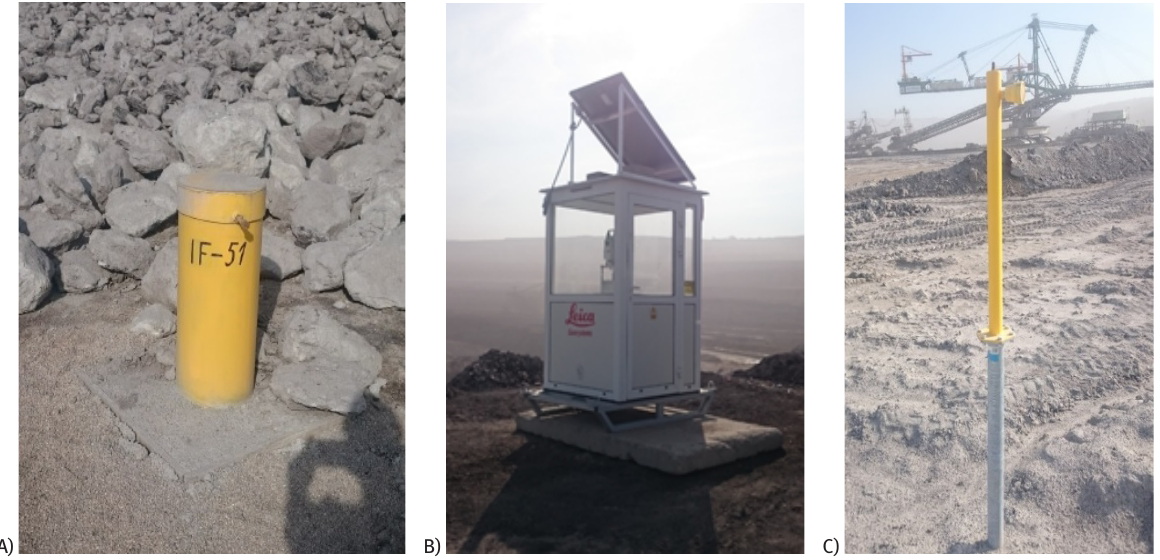
Figure 4: (A) Inclinometer, (B) box of the GeoMoS system, (C) the GeoMoS